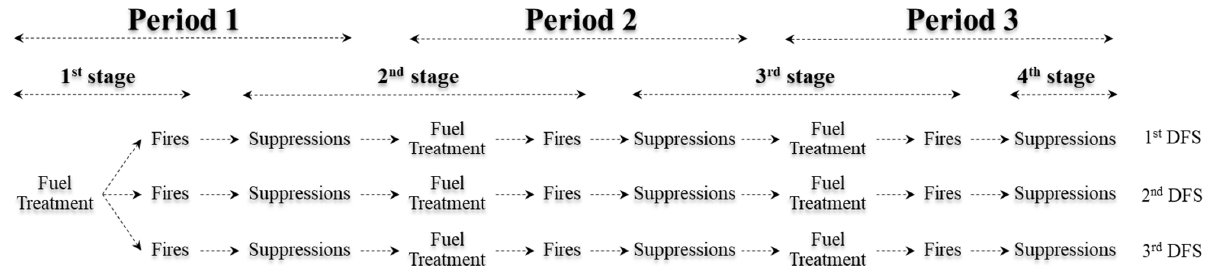
Figure 1. Illustration of a multistage stochastic sample average approximation (SAA) program with three planning periods and three decision-fire-sequence (DFS) samples (i.e., N = 3). Each DFS is a sequence of prescribed burning decisions, random fire events, and recourse suppression decisions across all three periods. We assume prescribed burning decisions will be made at the beginning of each period before any random fires in that same period is realized. Suppression decisions can be made to every specific fire after it is revealed.